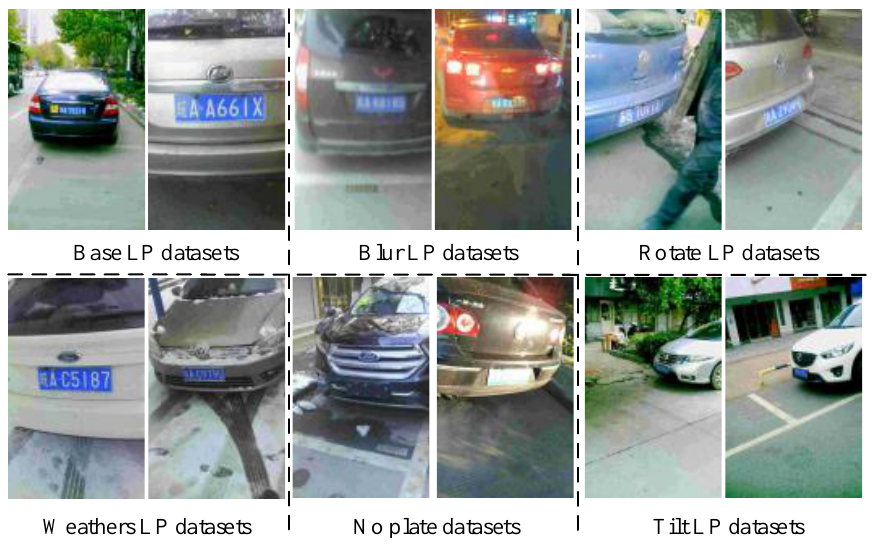
Figure 4. License plate test dataset examples.